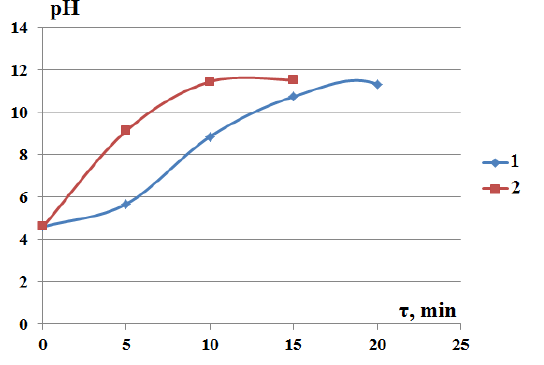
Figure 6. Variations of pH at: 1 - j =10mA·cm -2 ; 2 - 20 mA·cm -2 . For j=10 mA/cm 2